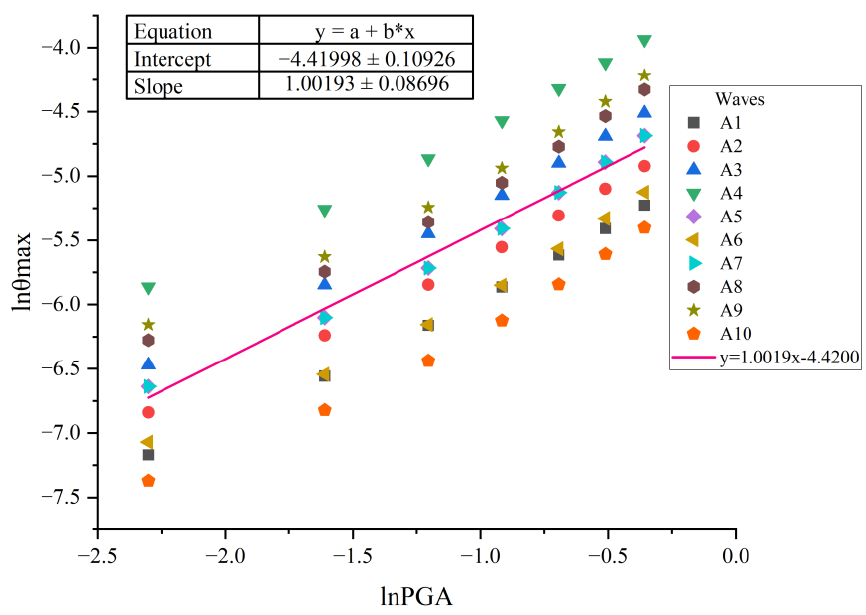
Figure 4. The fit of the ln θ max to the ln PGA .